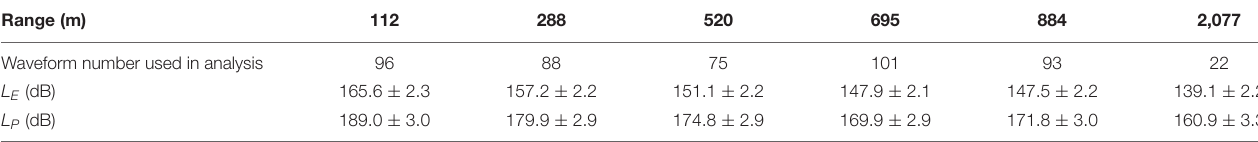
TABLE 1 | Sound exposure levels and peak pressure levels estimated for impact pile driving noise as a function of distance. Range